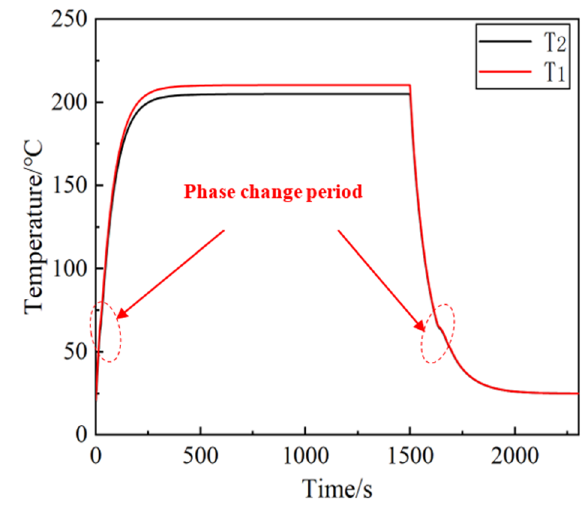
Figure 9. Temperature performance of the TEG system.